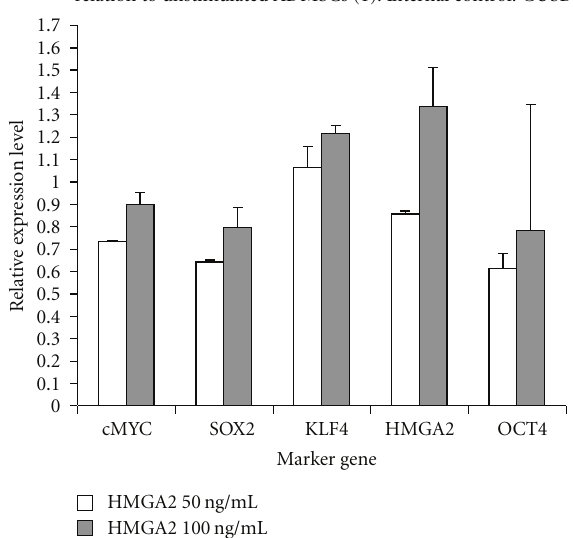
Figure 4: Marker gene expression in HMGA2 protein-stimulated (50, 100 ng/mL) and -unstimulated cASCs (1) after RT-qPCR. GUSB was used as endogenous control. All analysed genes (cMYC, SOX2, KLF4, HMGA2, and OCT4) are expressed in cASCs. No significant marker gene regulation could be detected after HMGA2 application in both